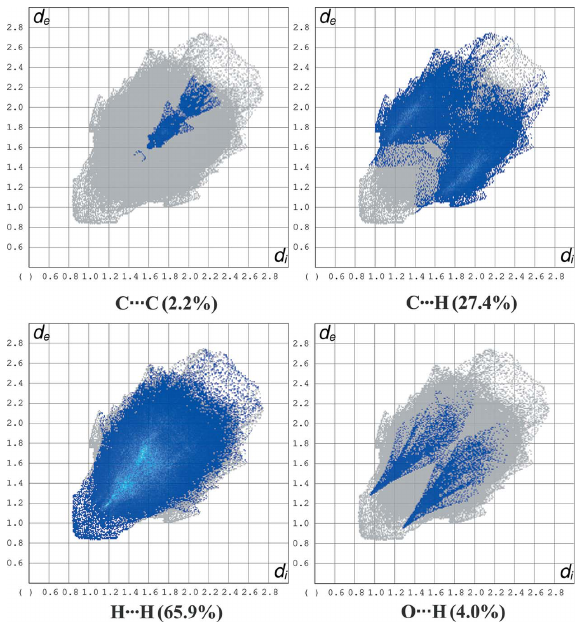
Figure 3 The two-dimensional fingerprint plots for compound 1 . close C (cid:2) (cid:2) (cid:2) C interplanar contacts and, therefore, (cid:2) – (cid:2) stacking interactions between Py ligands. For compound 2 , the bright-red spots on the Hirshfeld surface correspond to hydrogen bond O11—H11 A (cid:2) (cid:2) (cid:2) O8 with the diphenylacetic acid molecule, as well as weak C4— H4 (cid:2) (cid:2) (cid:2) O5 i and C17—H17 (cid:2) (cid:2) (cid:2) O4 ii hydrogen bonds between the O atoms of bridged diphenylacetate ligands and Bipy ligands (Fig. 7 and Table 2). Other observed red spots correspond to